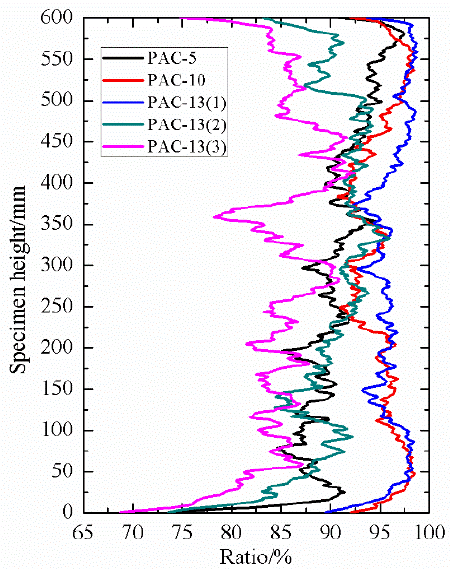
Figure 5. Area of pores along the specimen height direction.